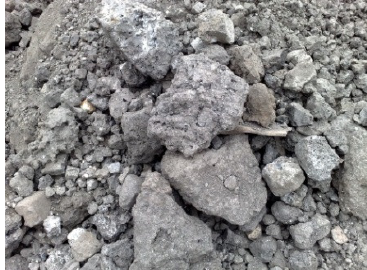
Fig. 1. Unfractionated BOF slag aggregate